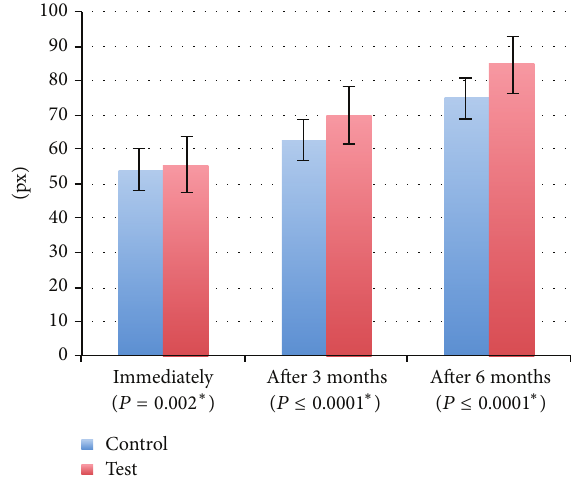
Figure 4: Mean and standard deviation for bone density (pixels). ∗ : statistically significant at 𝑃 ≤ 0.05 .